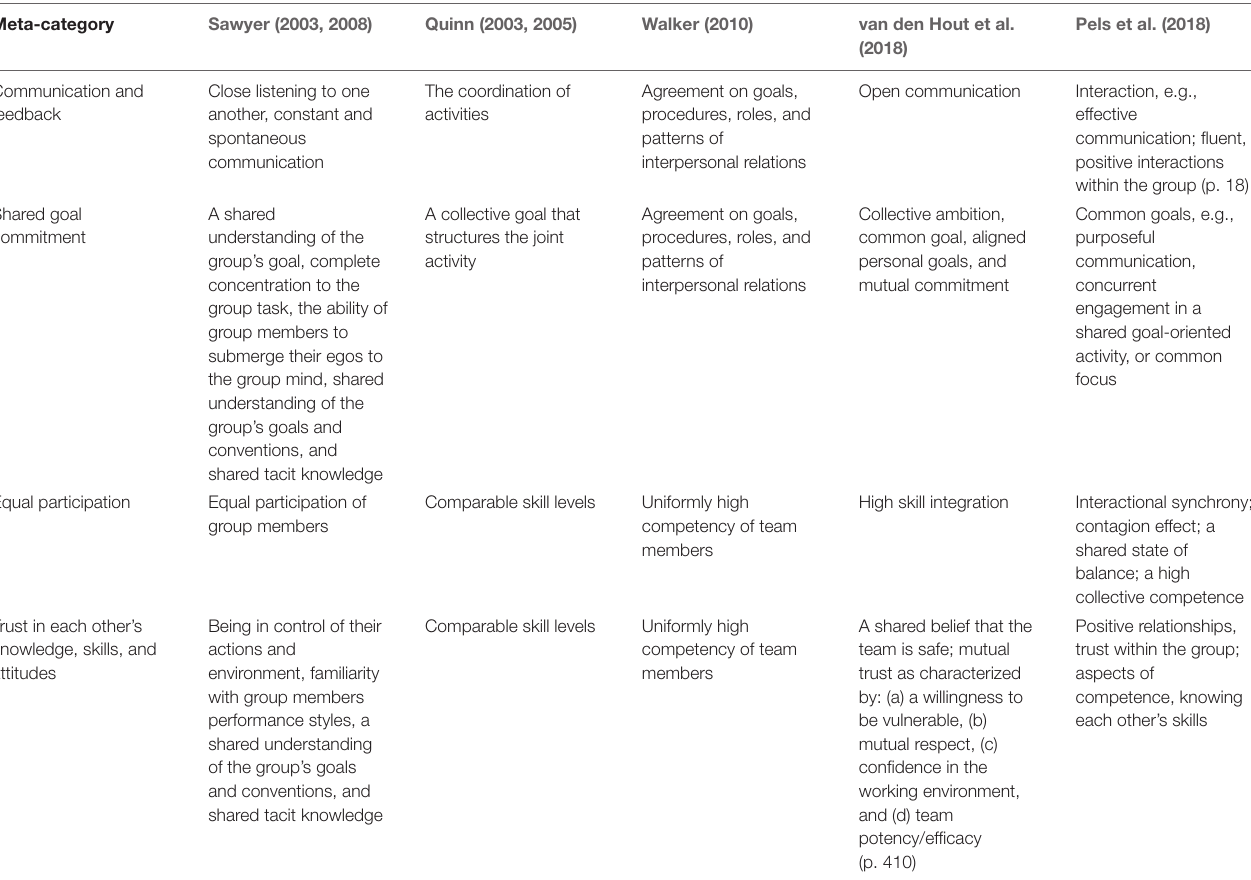
TABLE 1 | Meta-categories of team flow-specific characteristics.